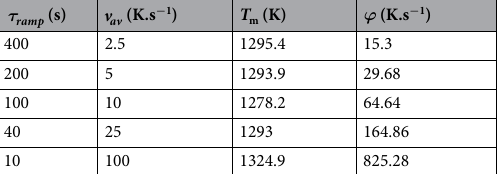
and ϕ ) of the heating schedules of duration τ m